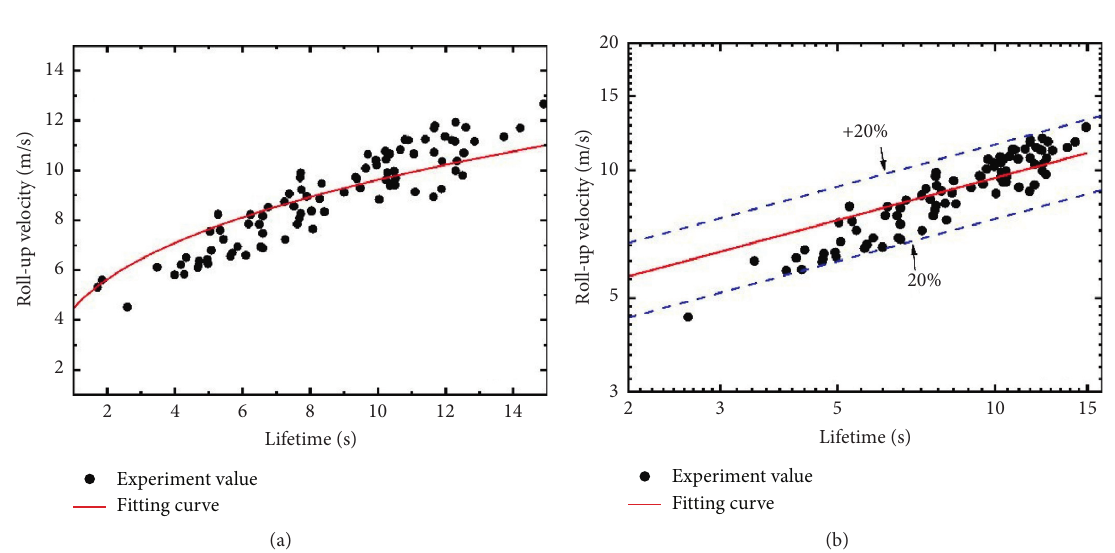
Figure 18: Correspondence between bubble roll-up velocity and lifetime of 0.05g/L TiO